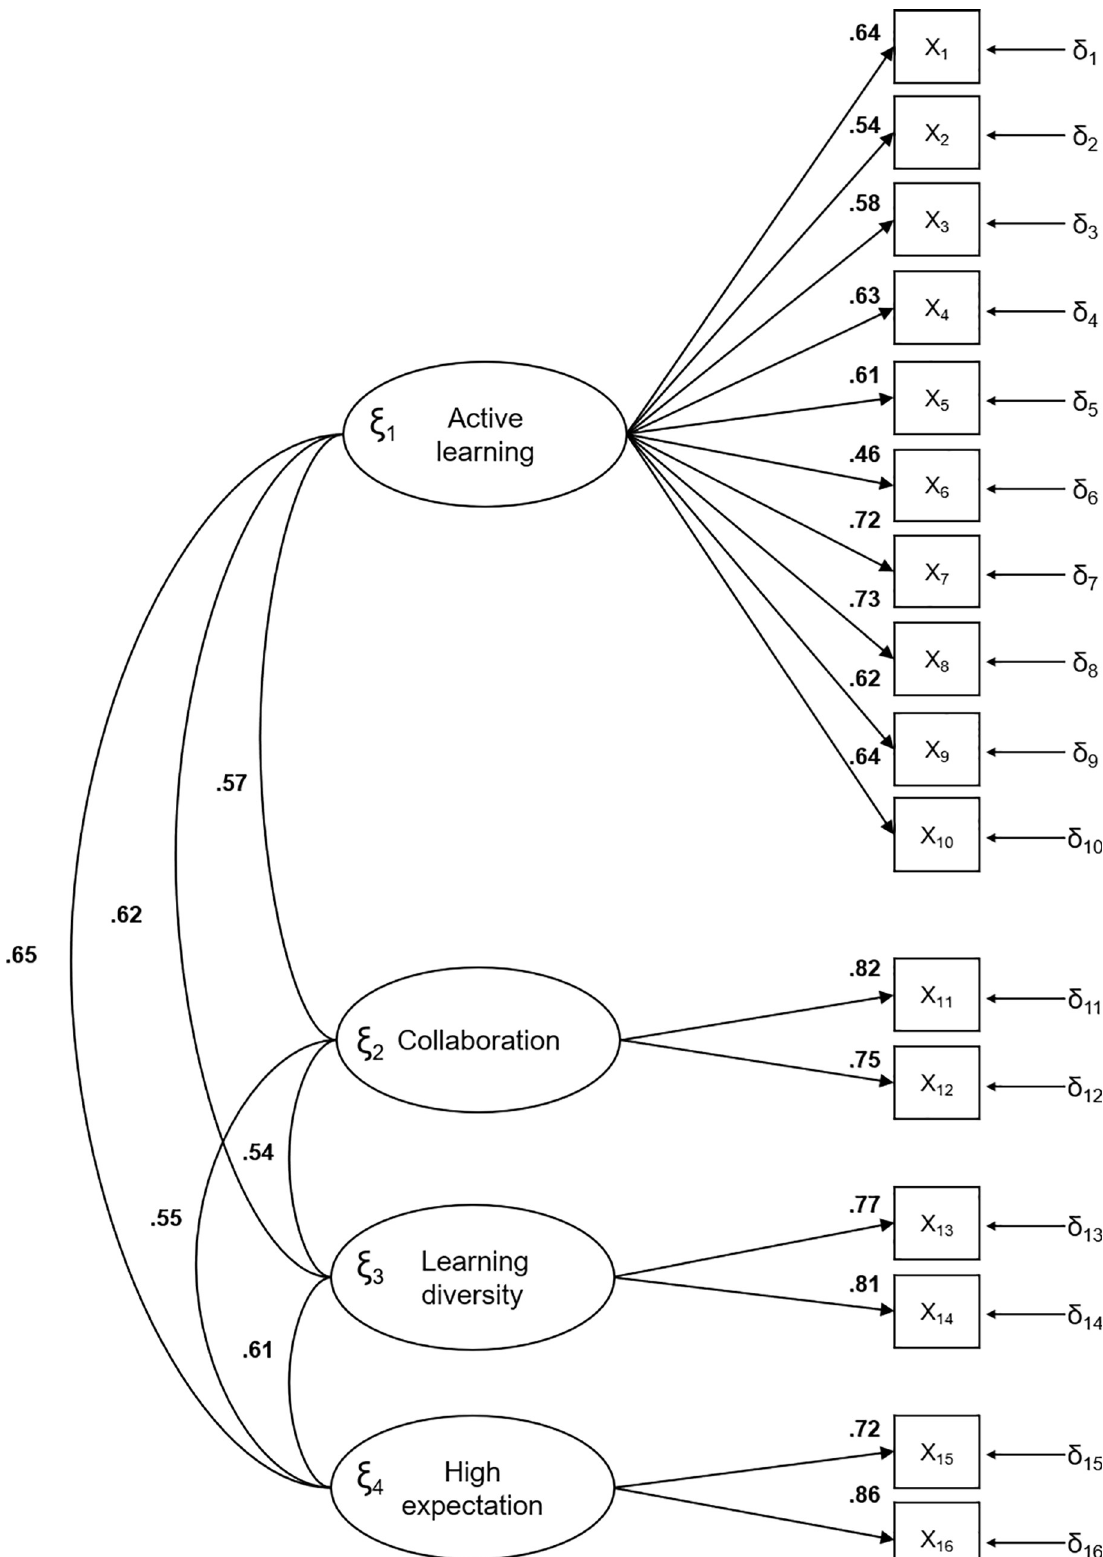
Fig 2. Standardized model parameters for the presence of educational best practices. https://doi.org/10.1371/journal.pone.0239014.g002 PLOS ONE | https://doi.org/10.1371/journal.pone.0239014 September 17,